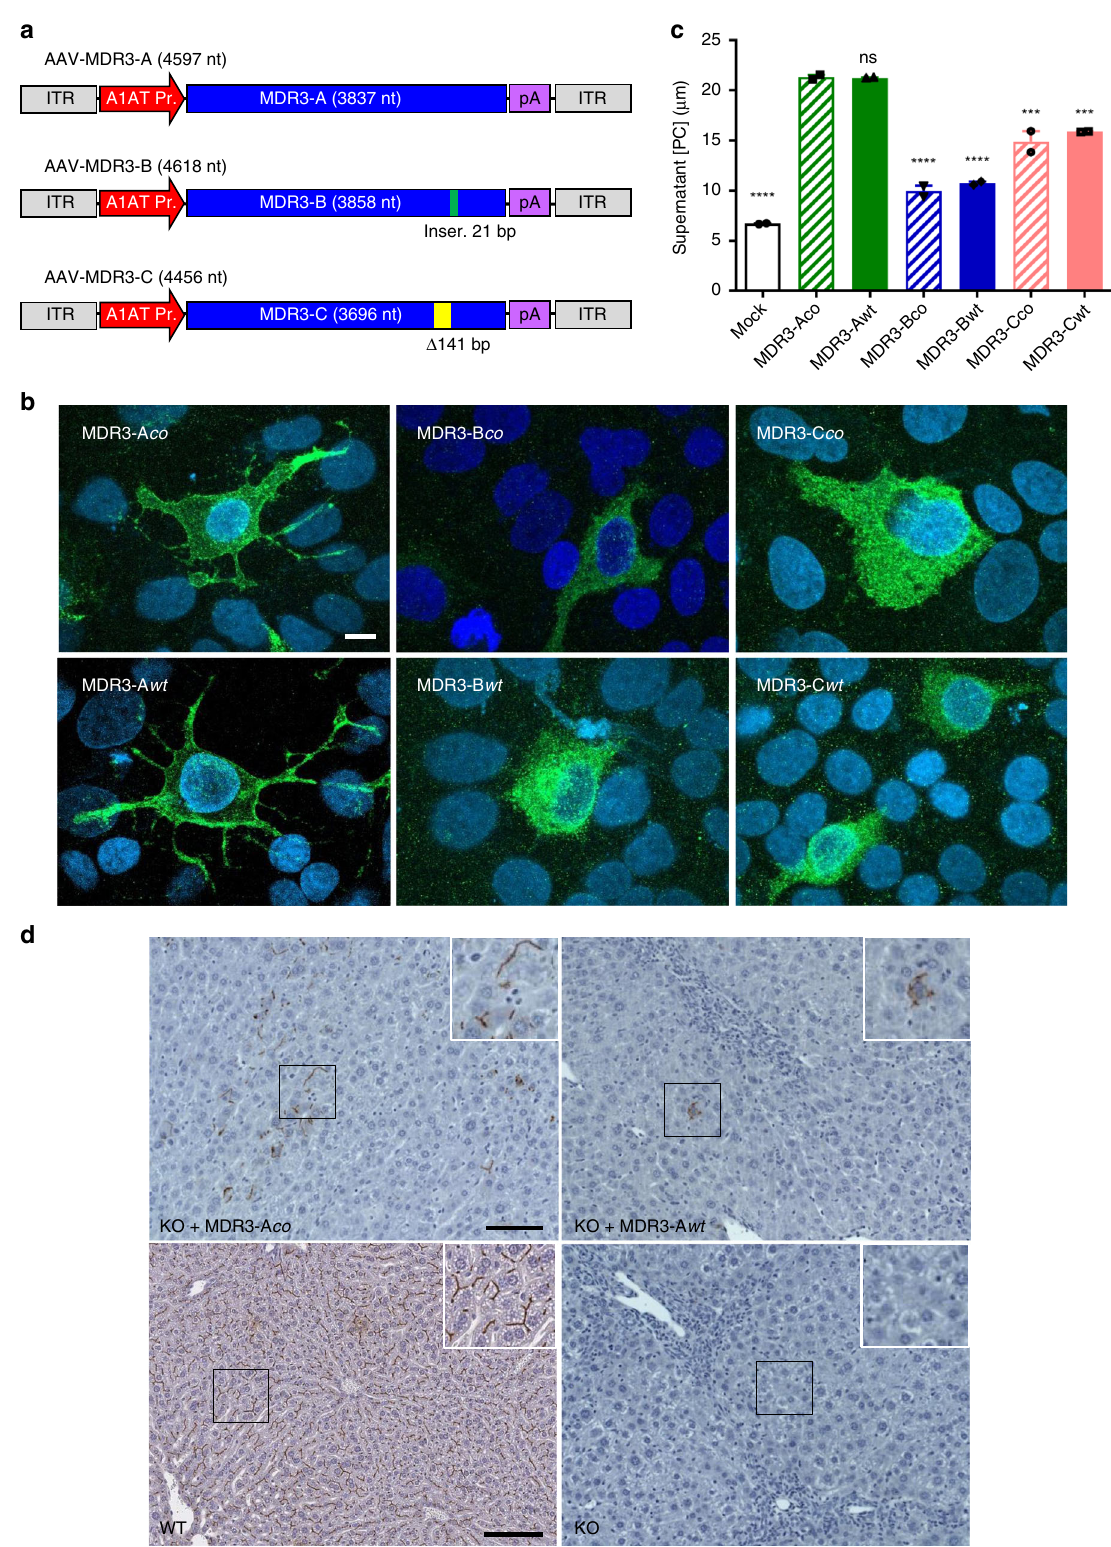
injection with AAV-MDR3-Aco at doses of 3 × 10 13 VG/kg (low) or 1 × 10 14 VG/kg (high) and monitored PFIC3 biomarkers in serum during the following 12 weeks. Male mice treated at the high dose achieved a sustained therapeutic effect up through 12 weeks, as ALP, alanine transaminase (ALT), aspartate